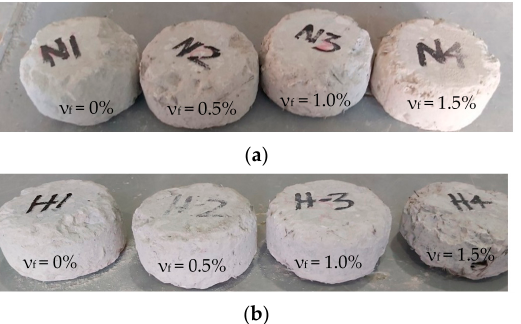
Figure 18. Appearance of specimens after the abrasion test: ( a ) NSC; ( b ) HSC.